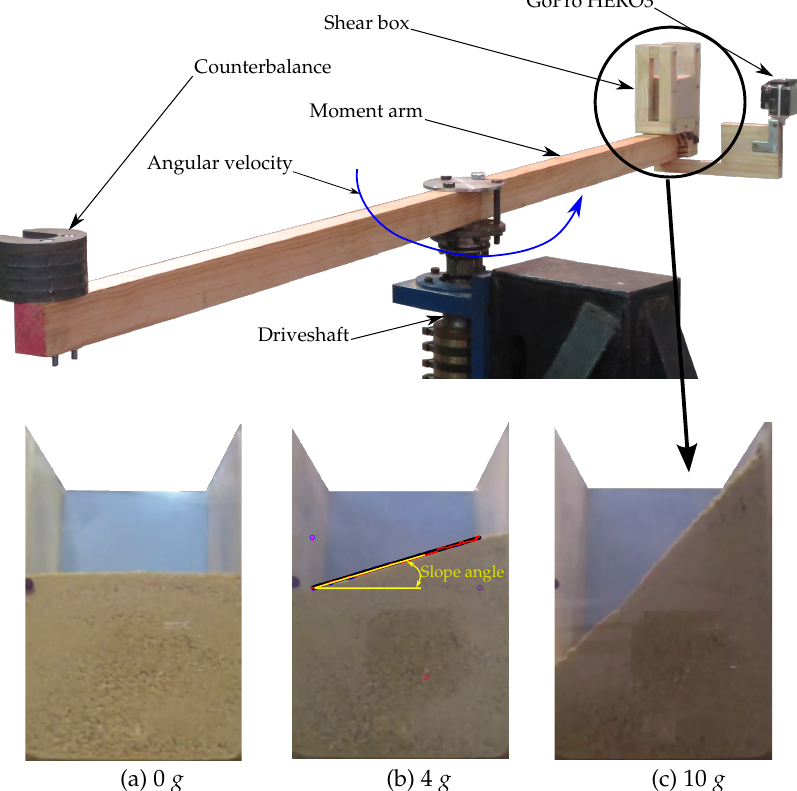
Figure 21. The centrifuge setup with the view from the camera shown in ( a ) for a lateral acceleration of 0 g , ( b ) 4 g and ( c ) 10 g